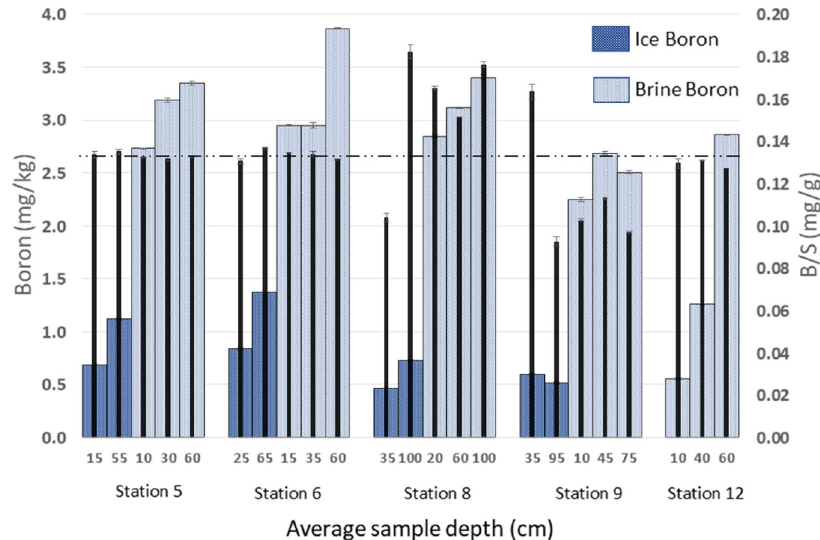
Fig. 3 Vertical pro fi les of total boron and boron to salinity ratios (B/S) across all fi ve ice stations. Wide bars represent total boron in ice (dark blue) and brine (light blue) and thin, solid bars (black) represent the B/S ratios. The horizontal dashed line represents the open ocean B/S ratio from Lee et al. 11 . Error bars represent uncertainty in replicate measurements ( n =